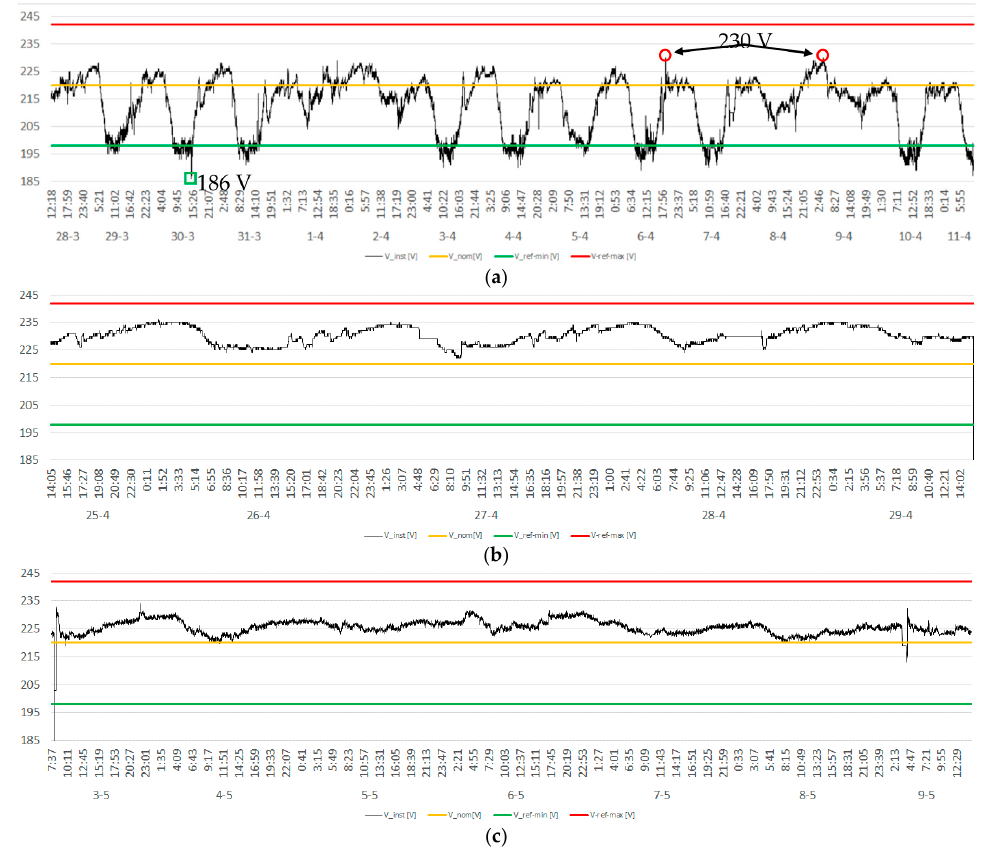
Figure 8. The voltage level on the grid during the measurement period in ( a ) Pekanbaru, ( b ) Kupang, and ( c ) Jayapura. Note the different time scales between the measurement locations. Red line: Highest limit for voltage, Yellow line: Average voltage, and Green line: Lowest limit for voltages.